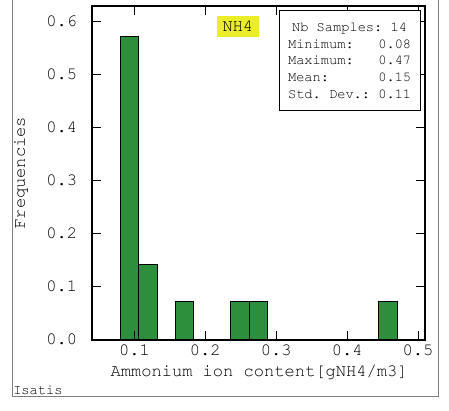
Fig. 6. Histogram of distribution of ammonium  NH ion content [g  NH /m 3 ] in underground water 4 4 for water intake area of Kłodzko (SW part of Poland); data coming from 14 wells